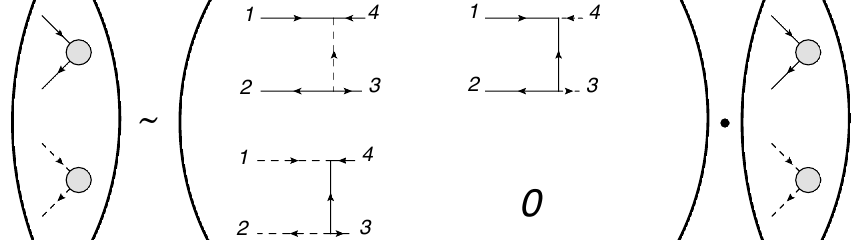
Figure 2. Kernels of the h i ( (cid:28) 1 ) (cid:22) i ( (cid:28) 2 ) j ( (cid:28) 3 ) (cid:22) j ( (cid:28) 4 ) i , h i ( (cid:28) 1 ) (cid:22) i ( (cid:28) 2 ) b j ( (cid:28) 3 )(cid:22) b j ( (cid:28) 4 ) i , h b i ( (cid:28) 1 )(cid:22) b i ( (cid:28) 2 ) (cid:22) )(cid:22) b )(cid:22) b j ( (cid:28) 3 ) j ( (cid:28) 4 ) i and h b i ( (cid:28) 1 i ( (cid:28) 2 ) b j ( (cid:28) 3 j ( (cid:28) 4 ) i correlation functions. Iterating these kernels to build ladder diagrams amounts to 2 (cid:2) 2 matrix